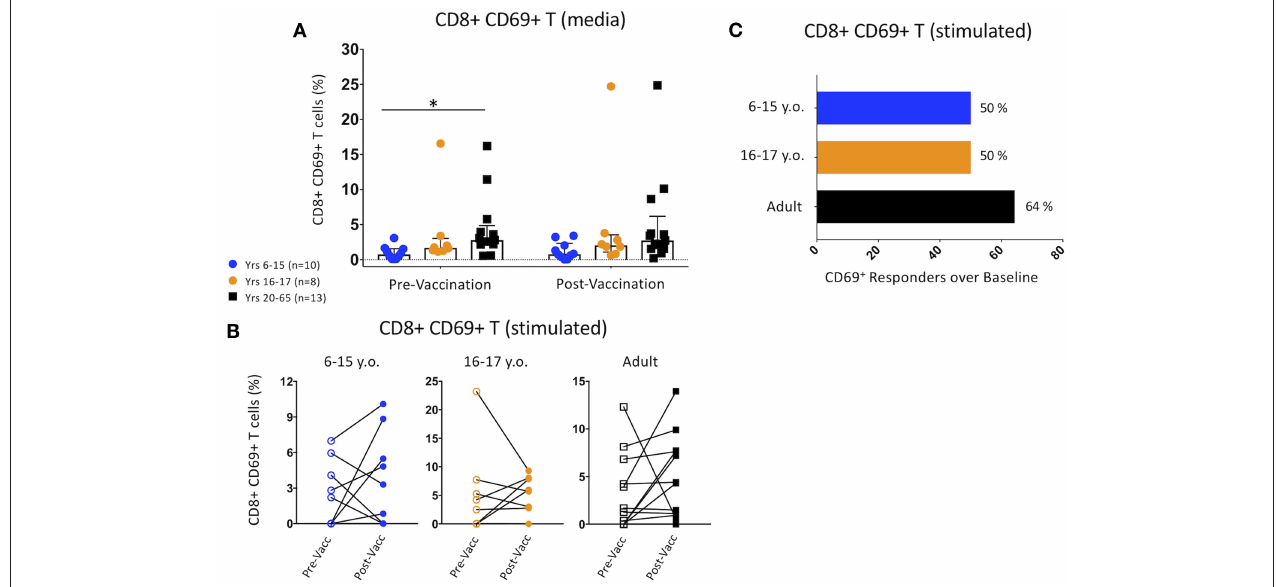
FIGURE 2 | Changes in Activated CD8 + CD69 + T cell Populations Following Ty21a Vaccination. (A) Scatter plot showing the percentages of CD69 + CD8 + T cells among pre- and post-Ty21a unstimulated PBMC (media). Bars represent medians with whiskers indicating interquartile ranges. (B) Connected dot plots showing each participants’ pre- and post-Ty21a CD8 + CD69 + expression levels following co-culture with S . Typhi-infected HLA-E restricted antigen presenting target cells. Data divided among 6–15 year-old pediatric ( n = 10), 16–17 year-old pediatric ( n = 8), and adult ( n = 13) participants. (C) Bars representing the proportion of CD8 + CD69 + responders over baseline levels (cut-off of 0.1%) following co-culture with S . Typhi-infected HLA-E restricted antigen presenting target cells. Statistics were analyzed by unpaired t -test. (* p <